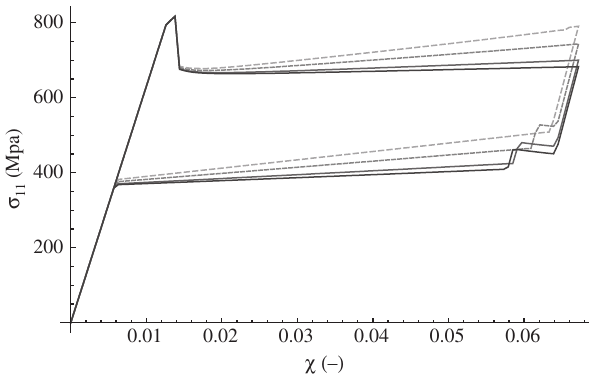
Figure 4 Relative value of the Euler angles over strain for varying heat conductivity κ ∈ {0.010, 0.015, 0.030, 0.050} GPa/K, = {2.62596, 1.84057, α 0